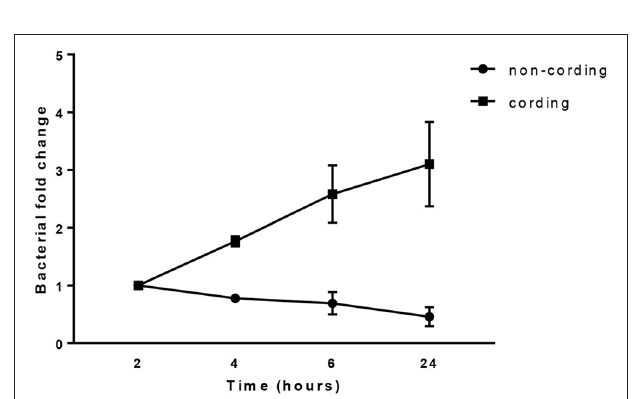
FIGURE 6 | Cording M. tuberculosis grow rapidly during infection. hMDMs from three different donors were infected with either shaken or standing cultures of H37Rv at MOI10. The bacterial growth was measured at 2, 4, 6, and 24 h. Bacterial fold change normalized to the initial time point. The total number of bacteria was obtained by measuring luminescence in both supernatant and cell lysate after the addition of the luciferase substrate